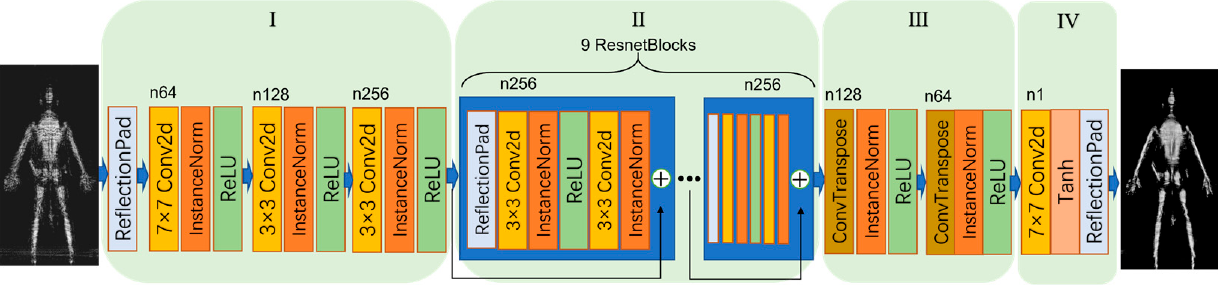
Figure 3. Generative architecture for the MMW deblurring Cycle GAN.